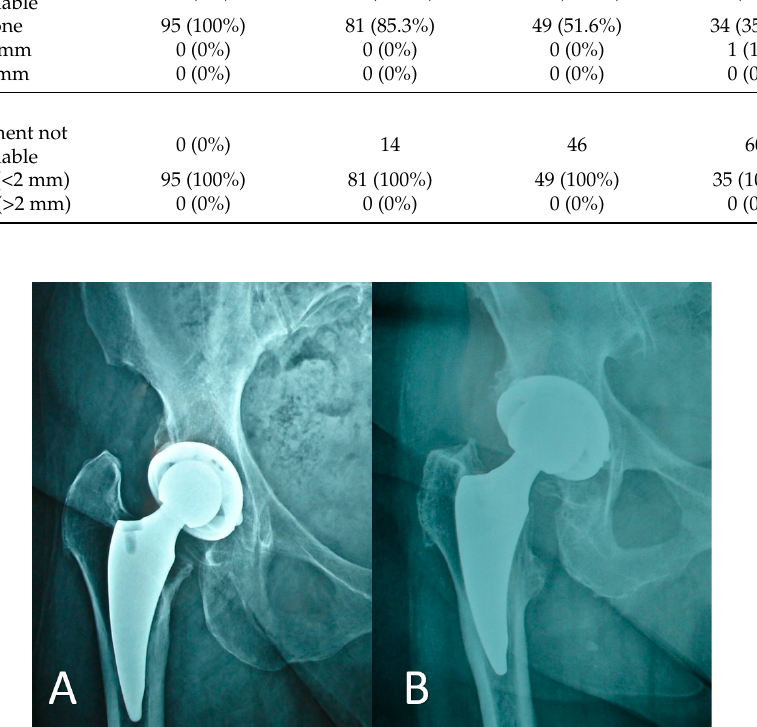
Figure 4. ( A ) DeLee and Charnley zone 2: a >2 mm radiolucency of the acetabular component. ( B ) Gruen zone 3: a femoral cortical hypertrophy. Table 4. Radiographic analysis of the DELTA ST-C cup during the follow-up period.